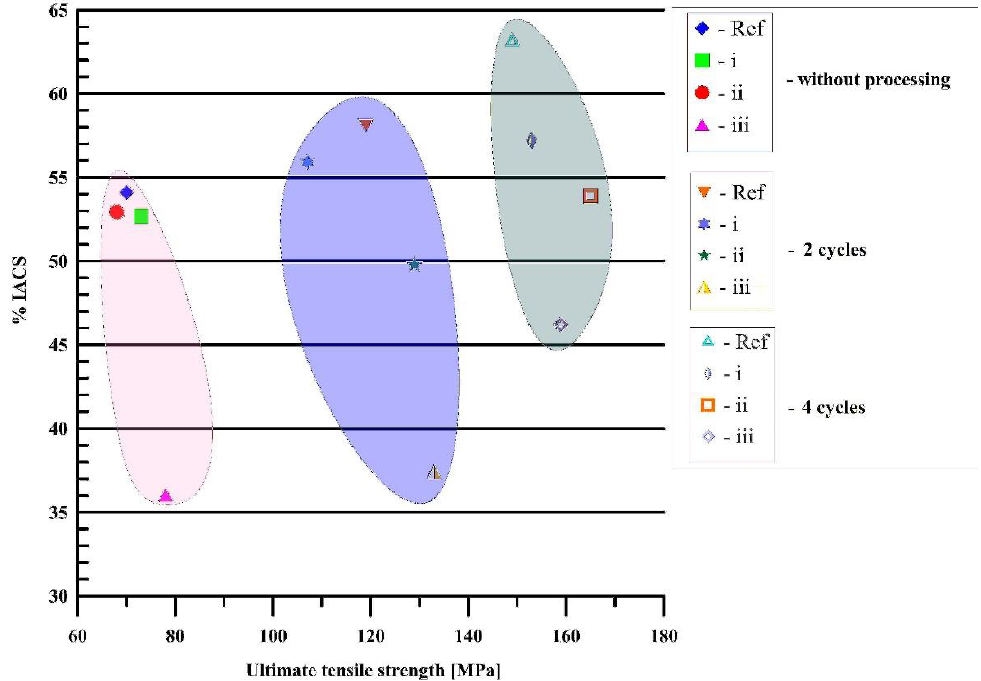
Figure 5. The electrical conductivity versus ultimate tensile strength of aluminum alloys.